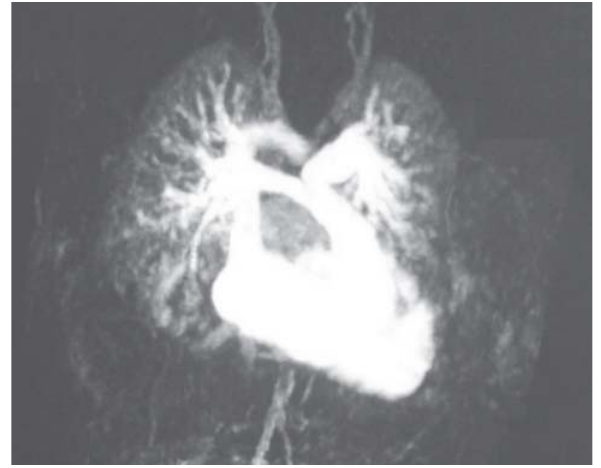
Fig. 2 - Angiorressonância nuclear magnética avaliando as